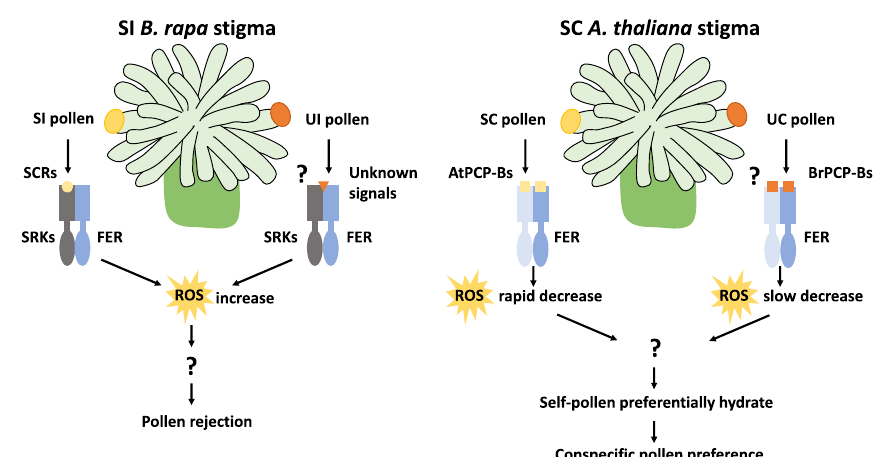
Fig. 1 FER‑ROS signaling is involved in the establishment of reproductive barriers in SI and possibly SC plants